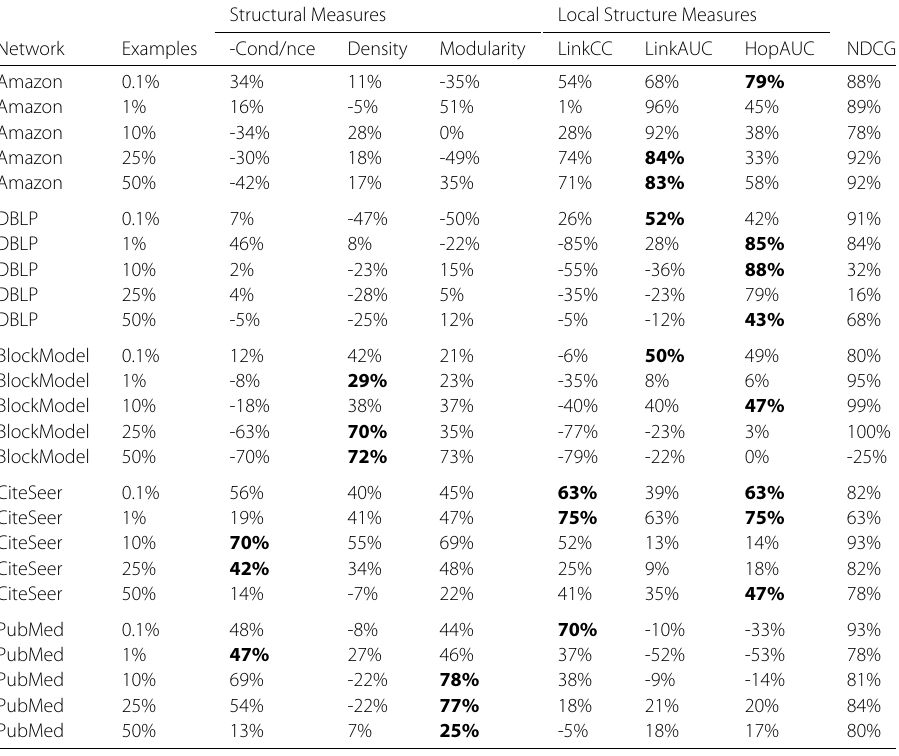
Table 3 Spearman correlation between other measures and AUC Structural Measures Local Structure Measures Network